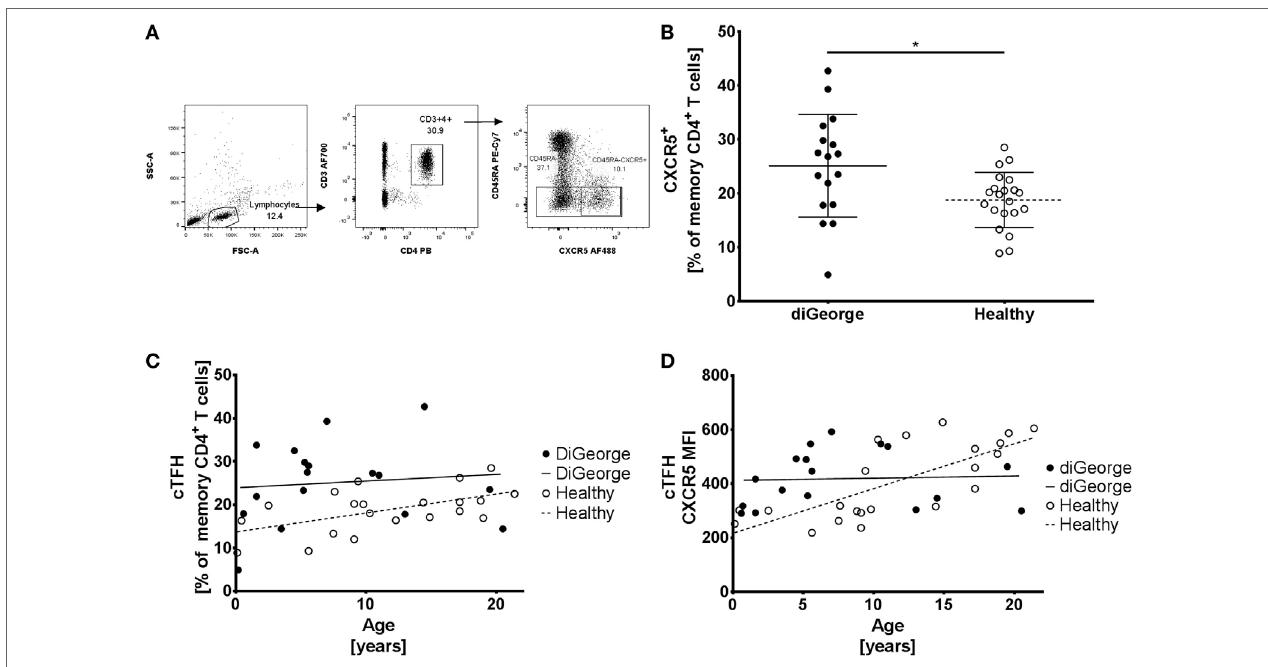
FigUre 2 | Gating strategy, circulating follicular helper T cells (cTFHs), and CXCR5 expression (a) Gating strategy of CD45RA − (memory) CD4 + T cells and CD45RA − CXCR5 + (cTFH) CD4 + T cells. (b) Proportion of cTFH in memory CD4 + T cells in DiGeorge syndrome patients and healthy controls shown in summary (lines denote mean ± SD) and (c) as development over time with linear regression trendlines. (D) Expression of CXCR5 on cTFHs over time (lines denote linear regression trendlines).